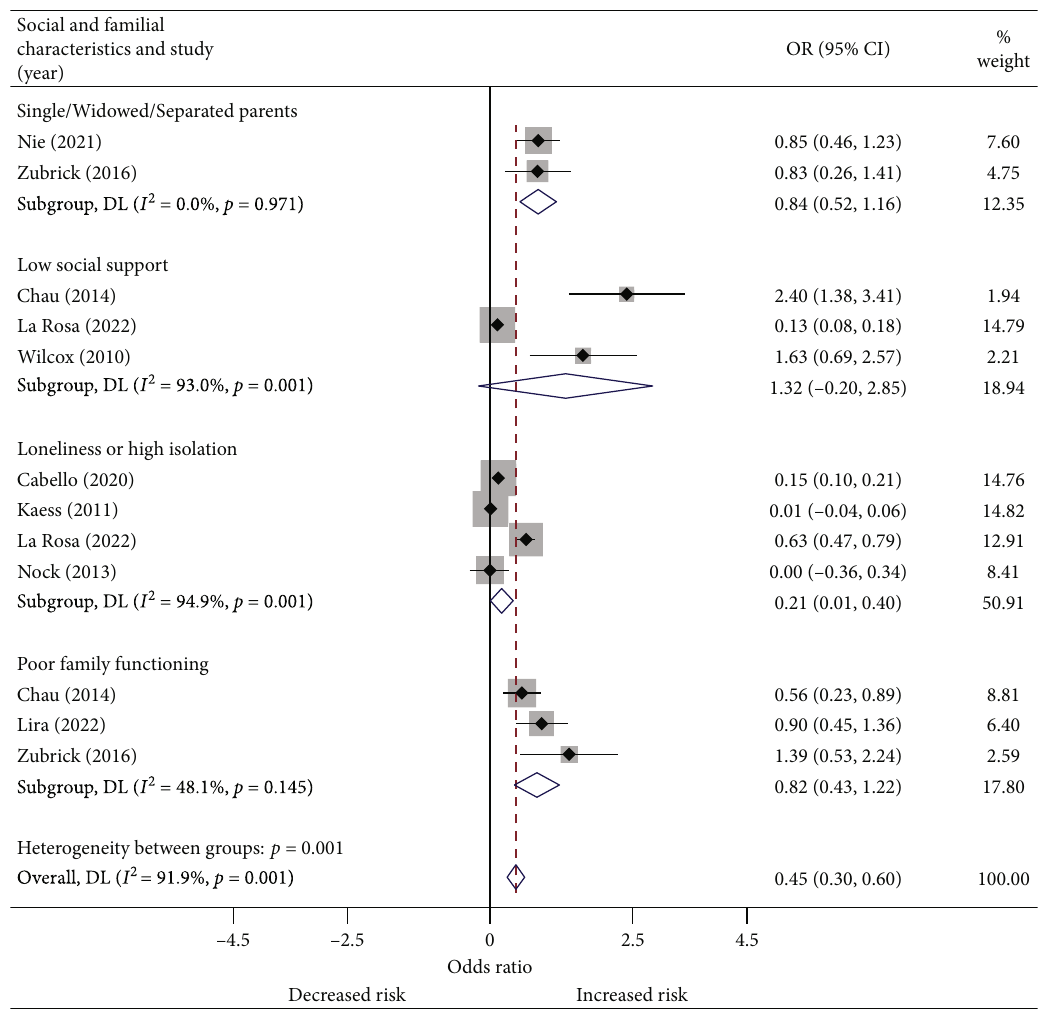
Figure 7: Social and familial characteristics as risk factors for suicide. Risk factor in this domain that is most strongly associated with suicide is loneliness or high